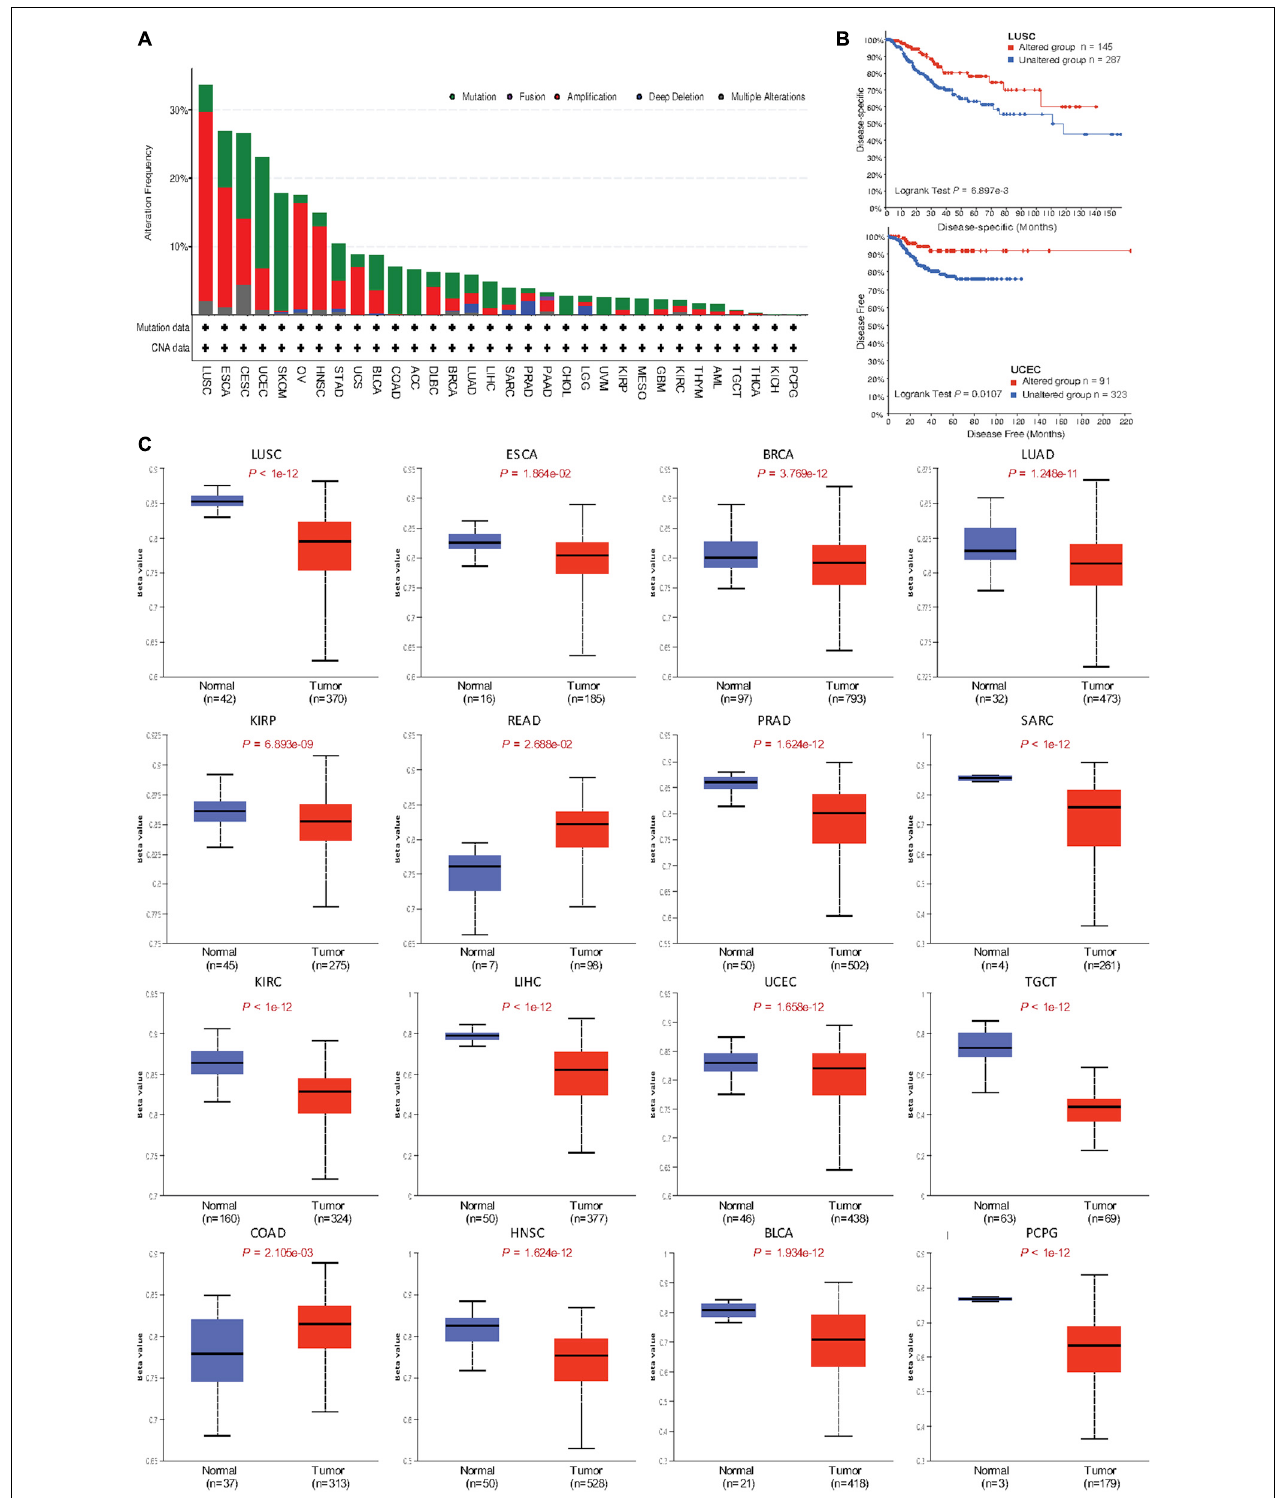
FIGURE 3 | Genomic alteration and methylation of MUC4 across different cancer types. (A) Alteration frequency of MUC4 across different cancer types in cBioPortal. (B) The prognostic value of MUC4 alteration in LUSC and UCEC. (C) MUC4 promoter methylation level in tumor and normal samples of the TCGA database in UALCAN. The beta value indicates level of DNA methylation ranging from 0 (unmethylated) to 1 (fully methylated). Different beta value cutoffs have been considered to indicate hyper-methylation [beta value: 0.7–0.5] or hypo-methylation [beta-value: 0.3–0.25].